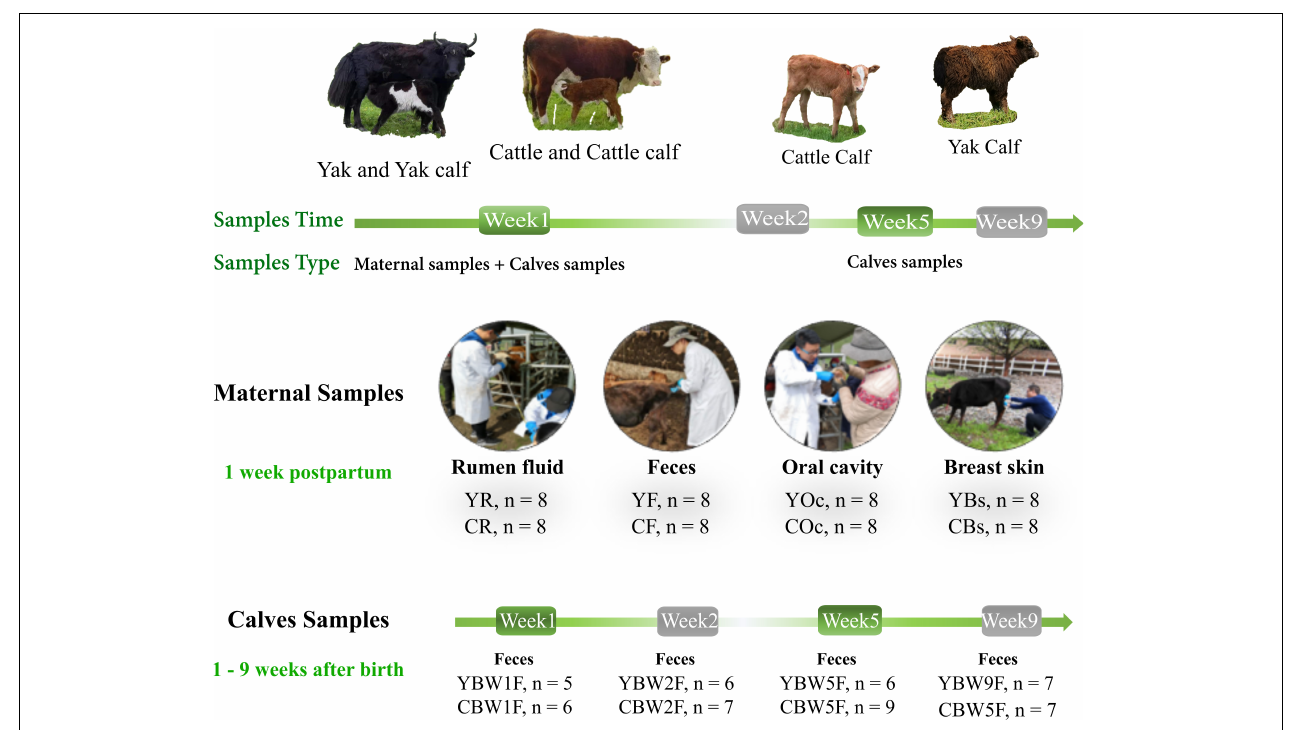
FIGURE 1 | Intestinal microbial source and succession analysis of yak and cattle calves on the same pasture at different weeks during pre-weaning. From June to August 2019, fecal samples were collected from yak calves (YB) and cattle calves (CB) at weeks 1 (W1), 2 (W2), 5 (W5), and 9 (W9) after birth by inserting a gloved finger into the anus of calf to stimulate defecation. Rumen fluid (R), feces (F), oral cavity (Oc), and breast skin (Bs) swabs from their mothers were also sampled at 1 week post parturition. YBW1F, YBW2F, YBW5F, and YBW9F represent fecal samples from yak calves at weeks 1, 2, 5, and 9 after birth; CBW1F, CBW2F, CBW5F, and CBW9F represent fecal samples from cattle calves at weeks 1, 2, 5, and 9 after